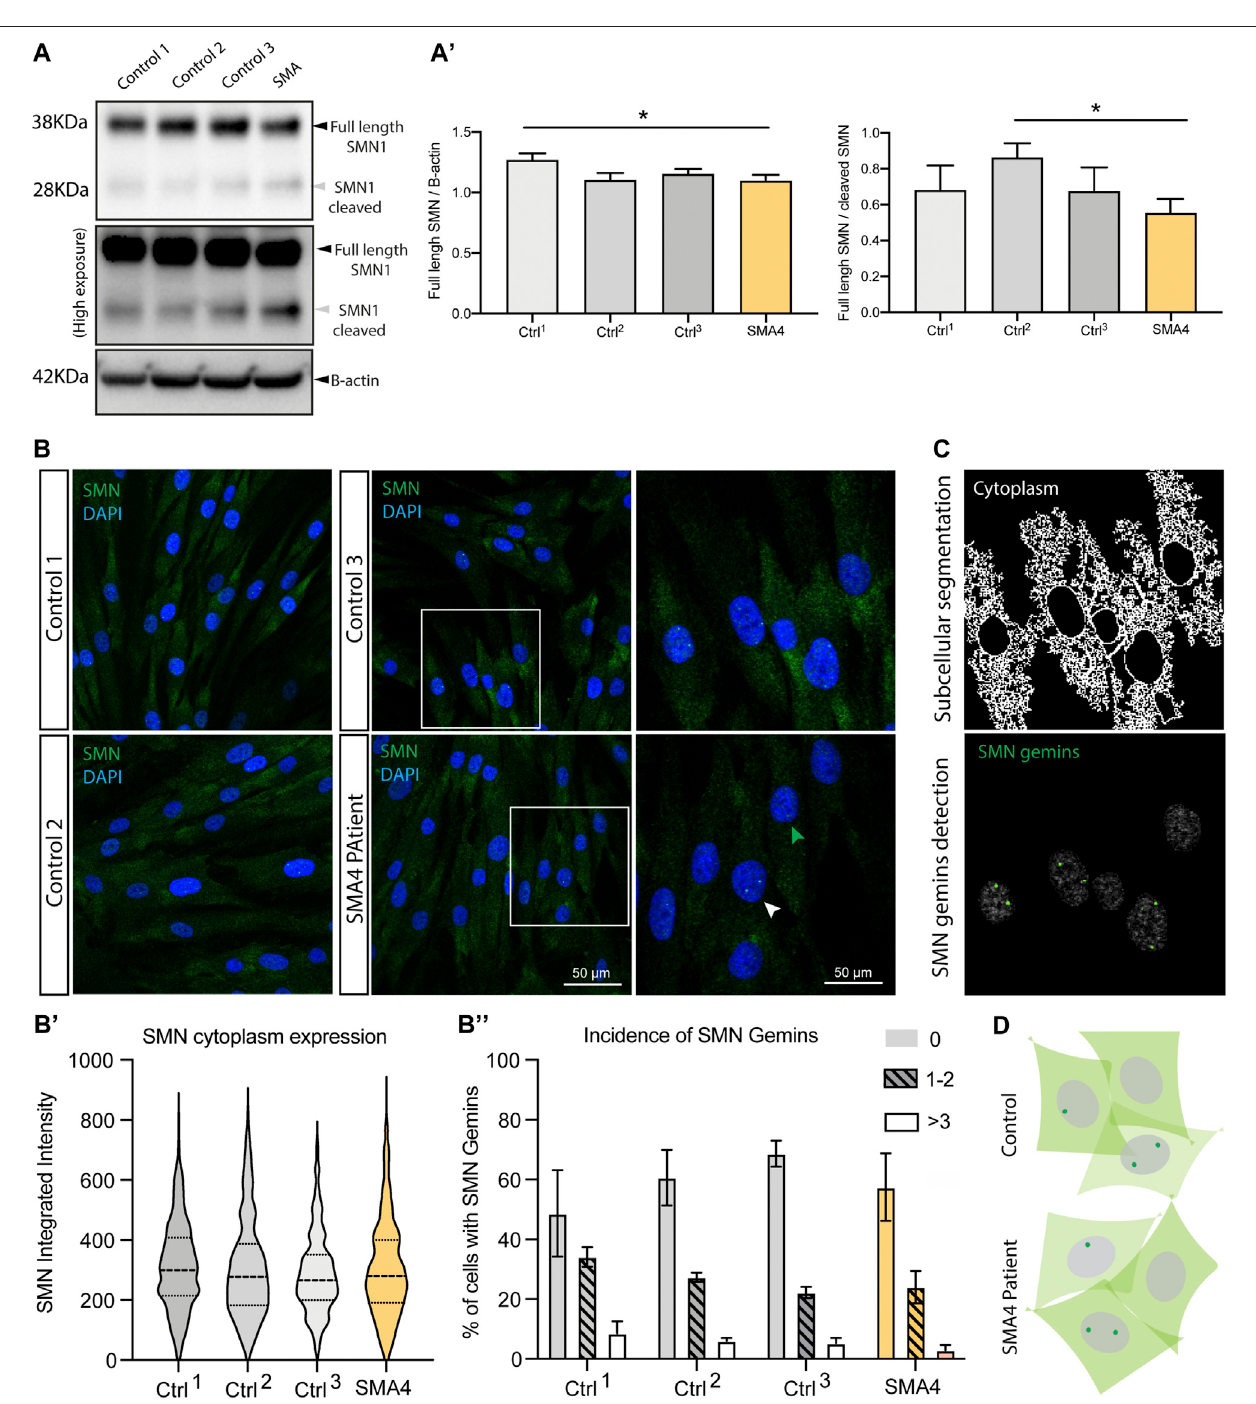
FIGURE3| SMNproteinlevelssubcellulardistributioninSMA4patient fi broblastsshownochangesinSMN1proteinlevelsorSMN1subcellulardistribution. (A) LevelsofSMN proteindeterminedbywesternblotanalysisinlysatesfromaSMA4patientandcontrol fi broblasts. β -actinwasusedasaloadingcontrolintheseexperiments.Highexpositionofthe membraneblots allow visualization ofboth the full length (FL) SMN (38 KDa) and the cleaved SMN fragment (28 KDa). (A) Theamount of FL SMN and FL SMN/cleaved SMN was determined and shown in bar graphs as the mean ± SEM for each cell line. (B) Immuno fl uorescence analysis in control and SMA4-derived fi broblasts detects SMN (green) distribution in cytoplasmic and within the nuclei(blue) localising to subnuclear structures (gemins). Boxed areas are enlarged to allow visualization of cells showing no gemins (green arrowhead) and nuclei with SMN-gemins (white arrowhead). (B) Quanti fi cation of the SMN cytoplasmic expression (integrated intensity) within each cell. Violin plot shows the full distribution of all data points acquired ( n > 250 cells). (B) Incidence of SMN-gemins shown in bar graphs (as the mean ± SEM from 3 separate experiments for each cell line) and distributedin3separatedgroups,includingcellsshowingnogemins(nopattern),cellsshowing1or2SMN-gemins(linedpattern)andnucleiinwhich3ormoreSMNgeminswere detected(clearbar). (C) Representativeexampleofthein-housedeveloped CellPro fi ler pipelinetoallowsegmentationofthecytoplasmandnucleargeminsintheimmuno fl uorescence experiments. (D) Representative cartoon showing subcellular expression of SMN in skin fi broblasts highlighting a similar distribution in control and SMA4-derived cells.